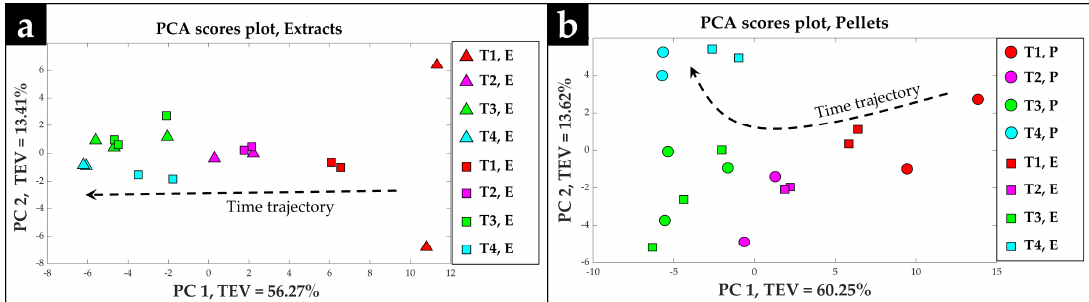
Figure 6. Procrustes analysis performed on the PCA scores of the GC-MS data generated from ( a ) cell extracts in both Manchester and Leuven and ( b ) cell pellets in Manchester and cell extracts in Leuven. Di ff erent colors indicate the various timepoints, while the symbols represent the sample sets, Manchester extracts (triangle, E), Manchester cell pellet (circle, P), and Leuven extract (square, E). The arrows illustrate the main trajectories with respect to time. The values in parentheses are total explained variance